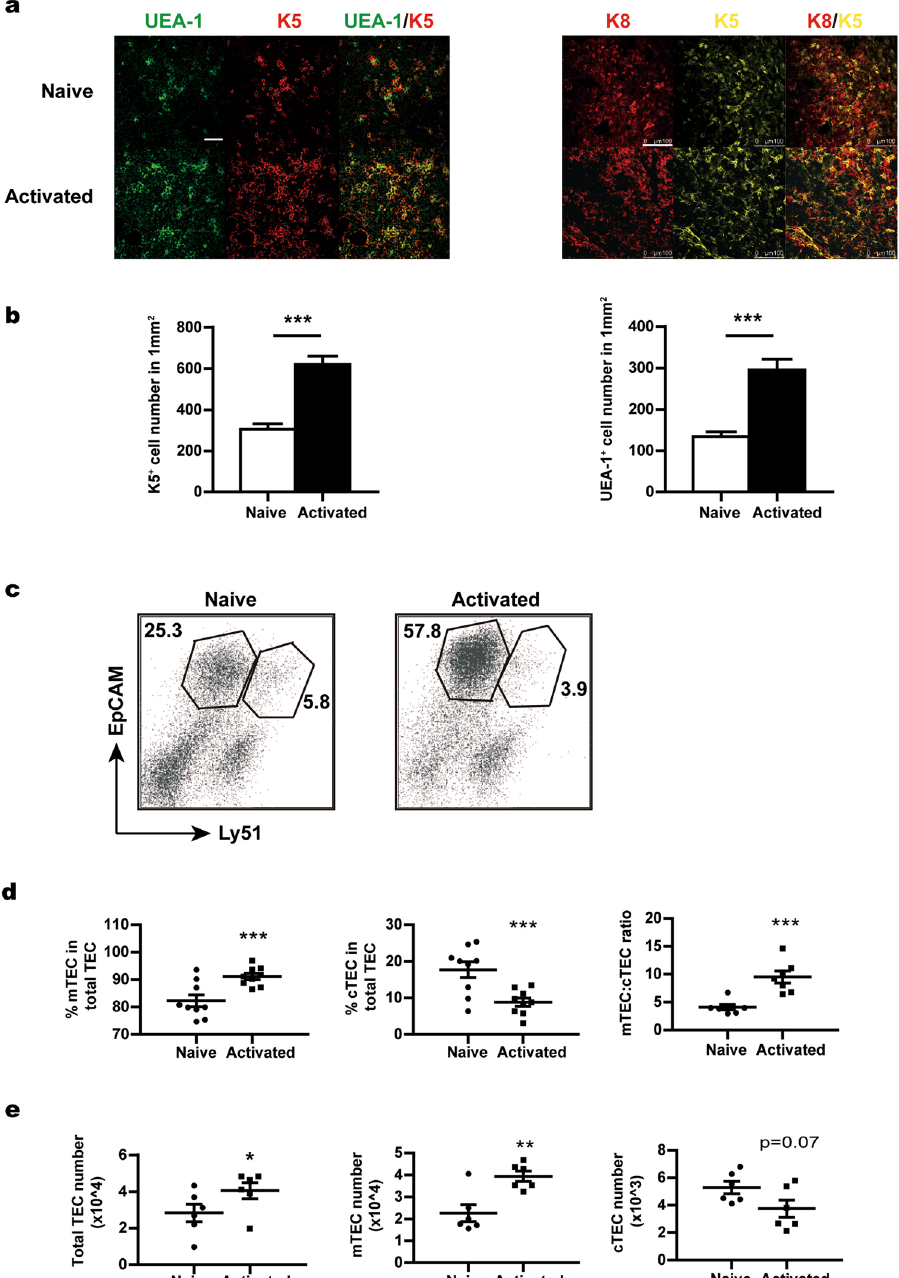
Figure 3. The distorted composition of thymic epithelial cells in the activated T cell-treated fetal thymus. Fetal thymuses were cultured in the presence of naive or activated CD4 + T cells and analysed at day 12. ( a ) Thymic lobes were examined by confocal microscopy to detect the expression of keratin 5 (K5) and keratin 8 (K8) and the binding activity for UEA-1. Representative images from three independent experiments are shown. Scale bars: 75 μ m for UEA-1 and K5 staining; 100 μ m for K8 and K5 staining. ( b ) The numbers of K5 + (left) and UEA-1 + (right) cells were counted in 10 randomly chosen sections of 370 × 370 μ m 2 and then converted into cell number per mm 2 . Data from three independent experiments are presented as Mean ± SEM. ( c ) Single cell suspension of thymic cells was prepared. MACS-enriched CD45 − stromal cells were stained with antibodies against CD45, EpCam and Ly51. Representative dot plots are shown with gates for mTECs (CD45 − EpCam + Ly51 − ) and cTECs (CD45 − EpCam + Ly51 + ). ( d ) The percentage of mTECs (left) and cTECs (middle) in total TECs and the ratio of mTECs versus cTECs (right). ( e ) The absolute number of total TECs (left), mTECs (middle) and cTECs (right). The experiments were repeated 6–9 times. Each experiment included 20–30 fetal thymic lobes for each group, which were then pooled for analysis. Each dot represents the result from a single experiment. Data are presented as Mean ± SEM. * p < 0.05, ** p < 0.01; *** p < 0.001; and ns, not